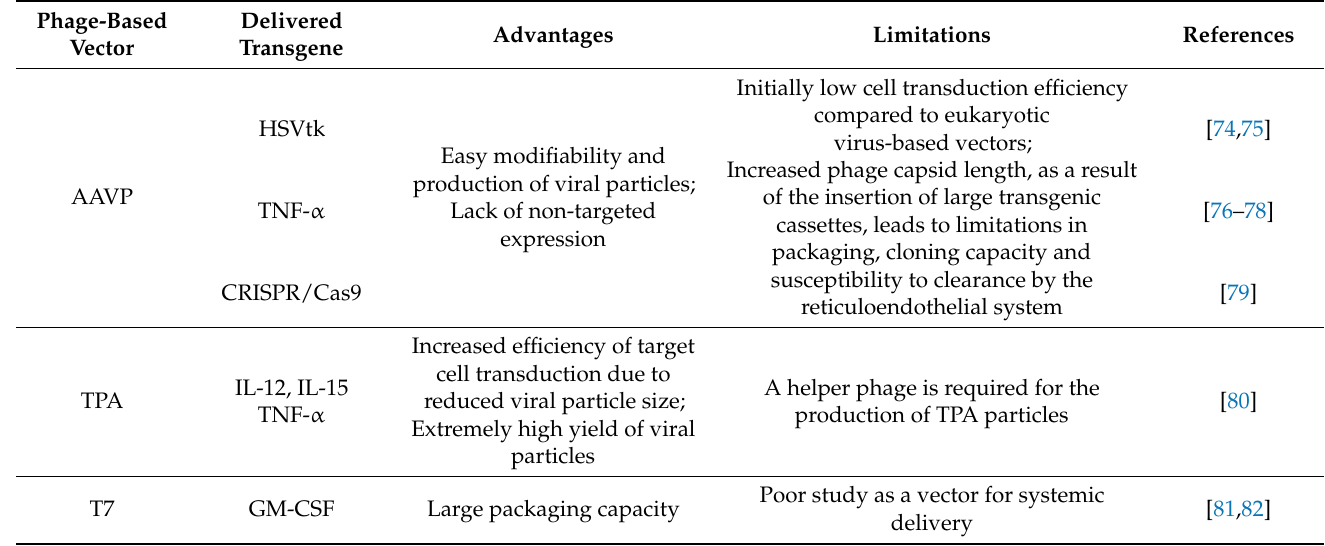
Table 1. Advantages and limitations of phage-based vectors used in tumor-addressing cancer gene